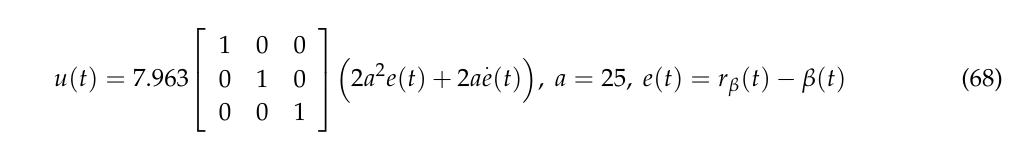
I (blue) of . (blue) of r y . y r y